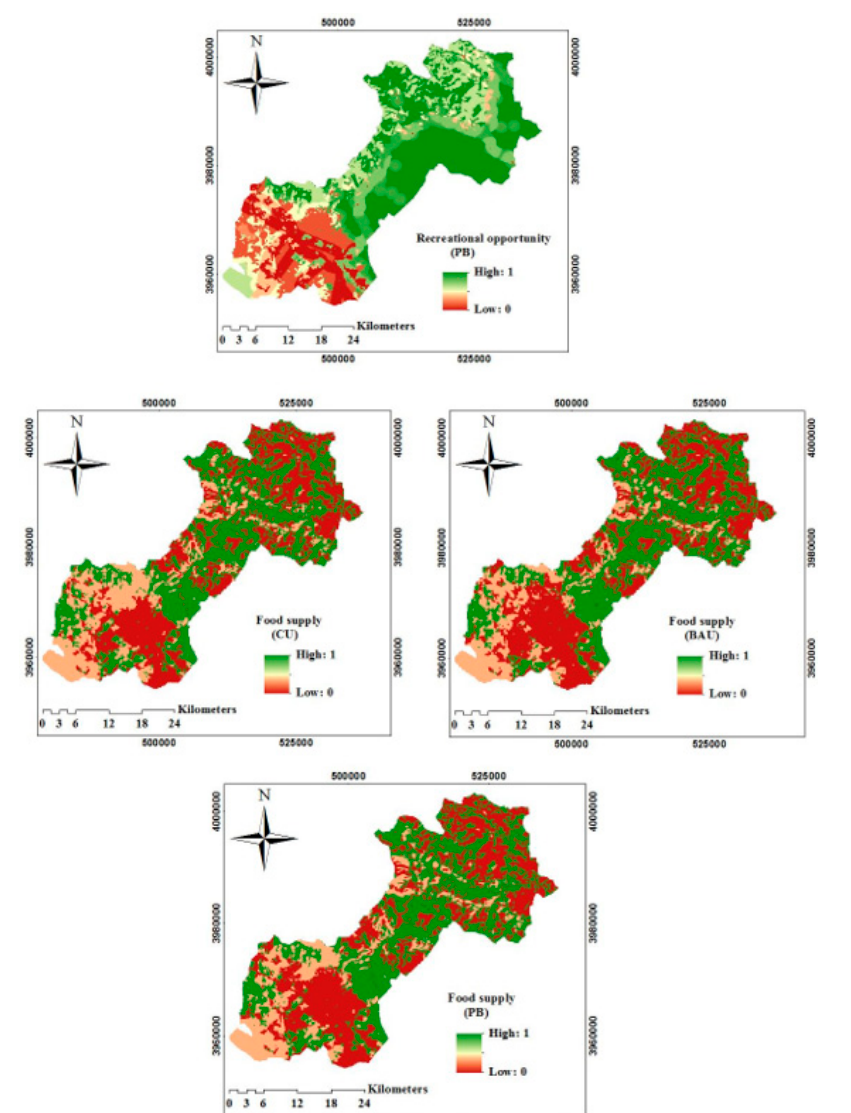
Figure 4. Spatial patterns of the ESs in the Karaj landscape.